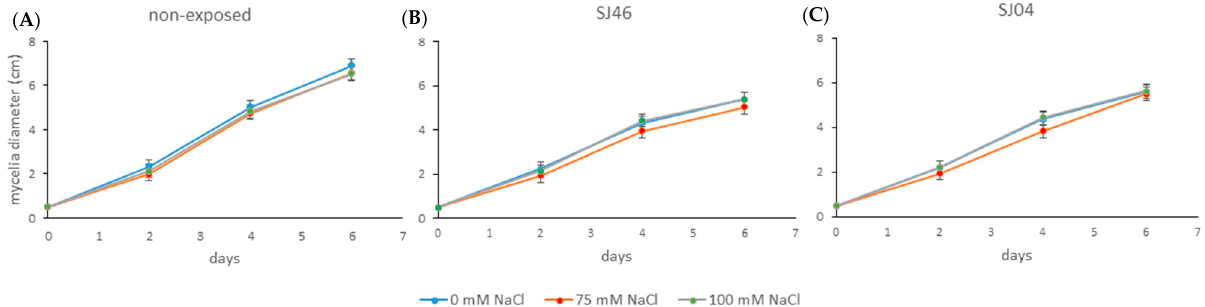
Figure 5. ( A ) E ff ect of the mVOCs of two PGPR, P. putida SJ46 and SJ04, grown under salt stress conditions (0 mM, 75 mM and 100 mM) on the growth of Sclerotium rolfsii on the fourth day of the challenge. ( B ) Photos of S. rolfsii cultures exposed to di ff erent treatments. Di ff erent le tt ers indicate statistically signi fi cant di ff erences. Fisher’s LSD test ( p < 0.05). The VOCs emi tt ed by SJ46 and SJ04 under salt concentrations had di ff erent e ff ects on the growth of S. rolfsii during the 4 days of the assay (Figure 6). Under 0, 75 and 100 mM, the VOC emissions of non-bacterial and SJ04 did not modify the growth of S. rolfsii on days 2 or 4 ( p > 0.05) (Figure 6A,C). However, the VOCs emi tt ed by SJ46 under salt stress (75 or 100 mM) increased the mycelium growth of S. rolfsii , but this was only observed on the fourth day ( p < 0.05) (Figure 6B).